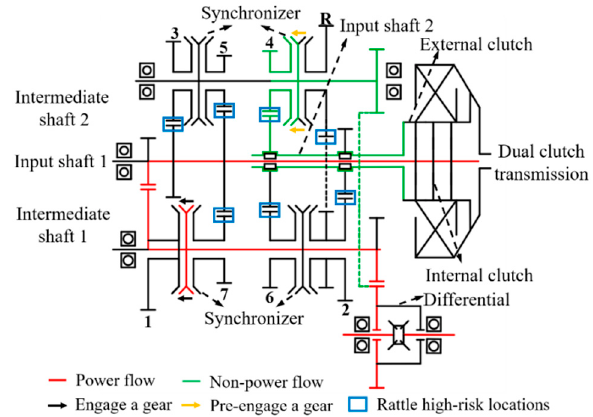
Figure 1. Structure diagram of dual clutch transmission. Figure 1 Structure diagram of dual clutch transmission